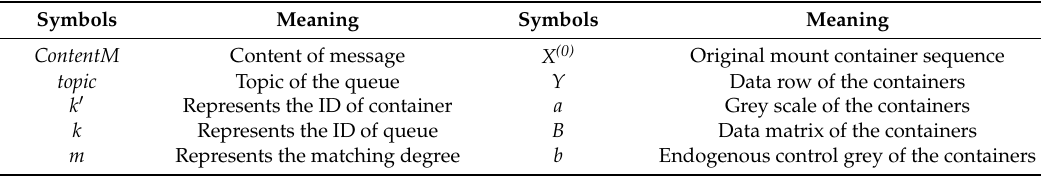
Table 1. Definition of the symbols used.